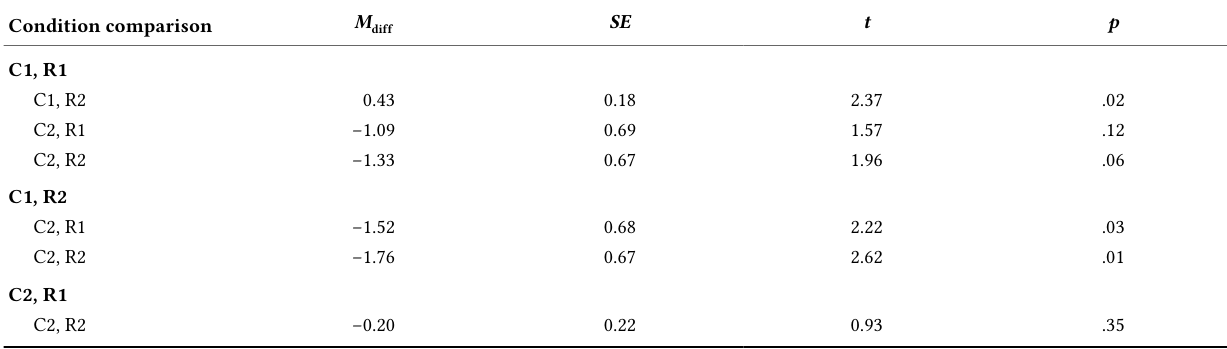
Table 11 indicates the results for the specific research question for Experiment 2.